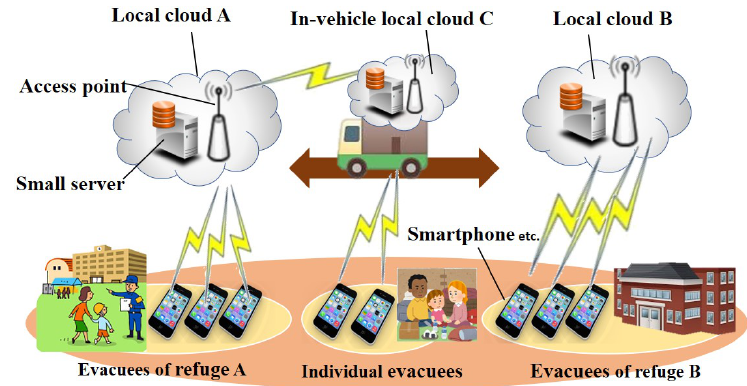
Figure 3. Use of LACS for disaster